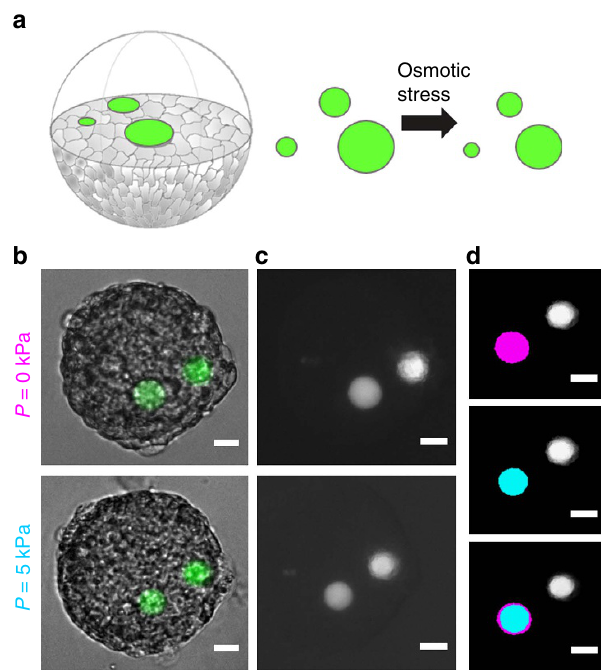
Figure 3 | Experimental approach to measure pressure propagation. ( a ) Schematic ilustration presents the concept of the application of microbeads as pressure sensors within multicellular spheroids. Upon externally applied stress, embedded beads undergo compression as shown in b , c . Bright-field images ( b ) serve to the contour of spheroids at equatorial plane. ( c ) Fluorescence of beads have been used to determine the surface before and after applied stress. ( d ) Present masks created upon IsoData threshold. The difference of surface area (magenta represents state before and cyan represents state after compression) as shown by superimposed images is converted into the strain, | V ( P ) (cid:2) V 0 |/ V 0 , for each bead found in focus. Scale bar, 20 m m ( b – d